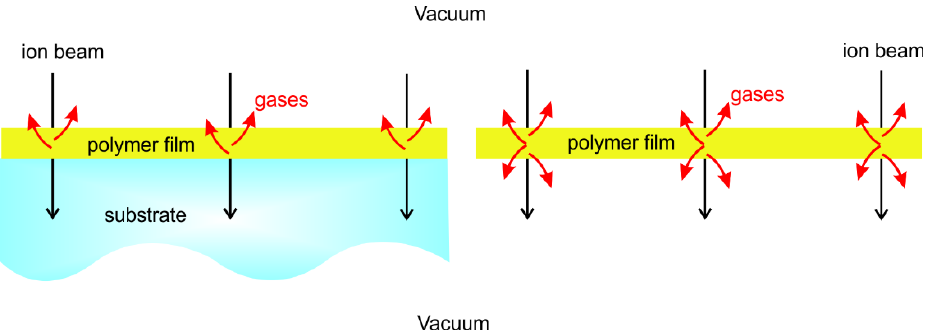
Fig. 1. Schematic illustration of the degassing of the polymer